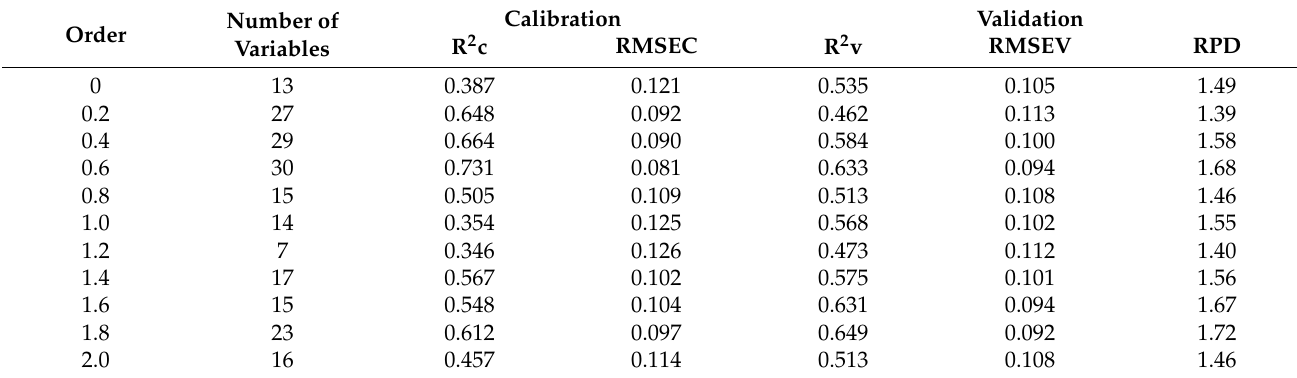
Table 3. SPA-PLSR modeling results under different